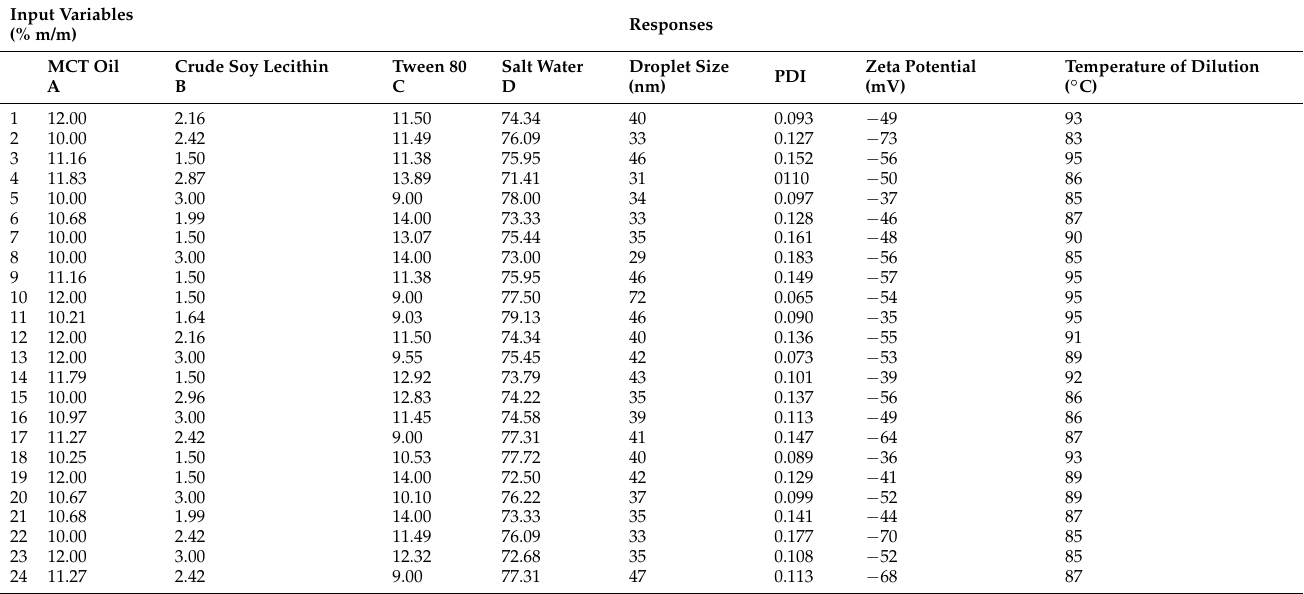
design algorithm generated 24 blends summarized in Table 3, along with their respective values for the droplet size, polydispersity index and zeta potential. Table 3. Blend compositions generated by I-optimal design and observed experimental data.